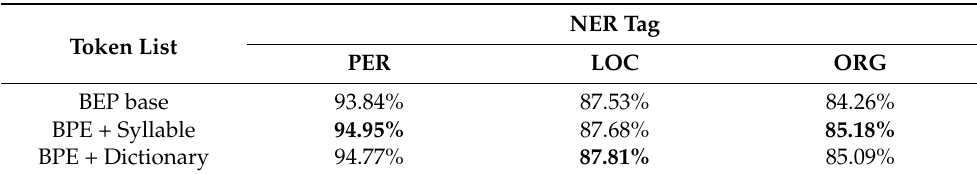
Table 5. Details of named entity recognition results in small language models; PER (person), LOC (location), and ORG